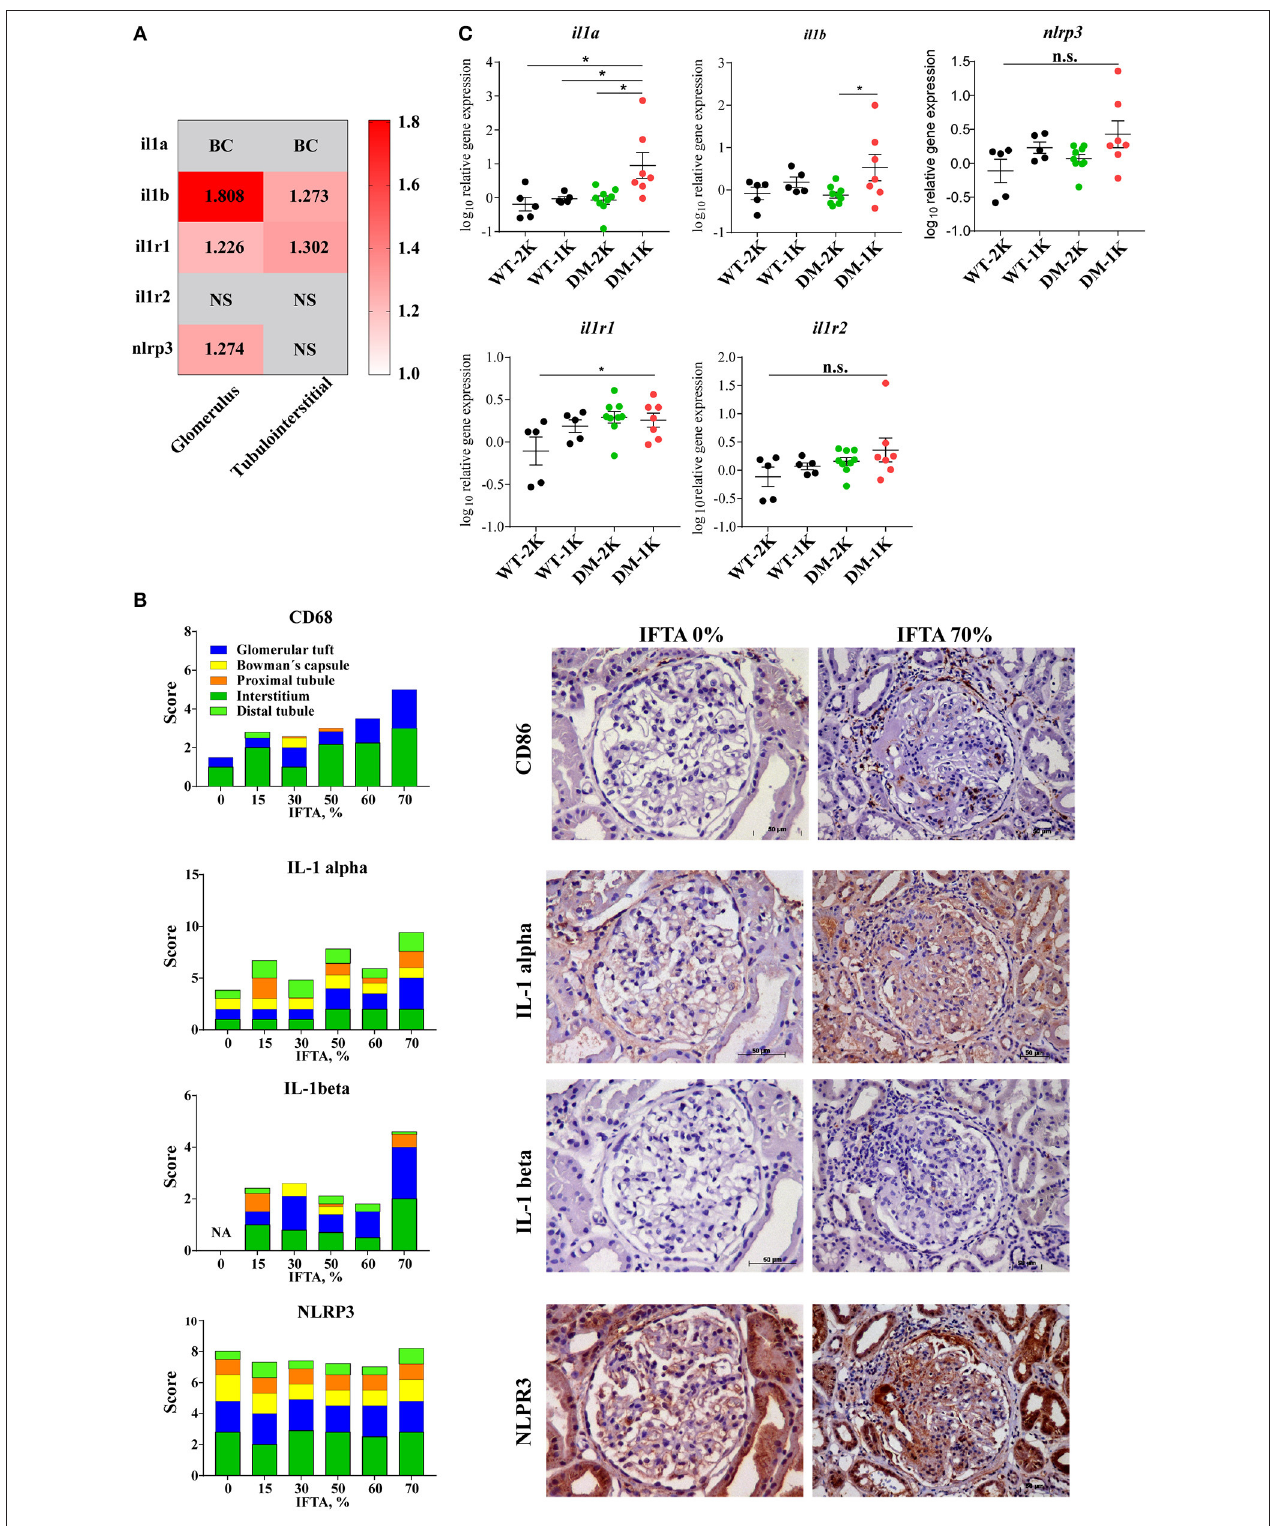
FIGURE 1 | IL-1 β expression in diabetic kidney disease. (A) Gene expression data of microdissected glomeruli and tubulointerstitium from kidney biopsies of patients with diabetic glomerulopathies and living donors as controls. IL-1 β , IL1R1 gene expression was upregulated in both glomeruli and tubulointerstitium in diabetic